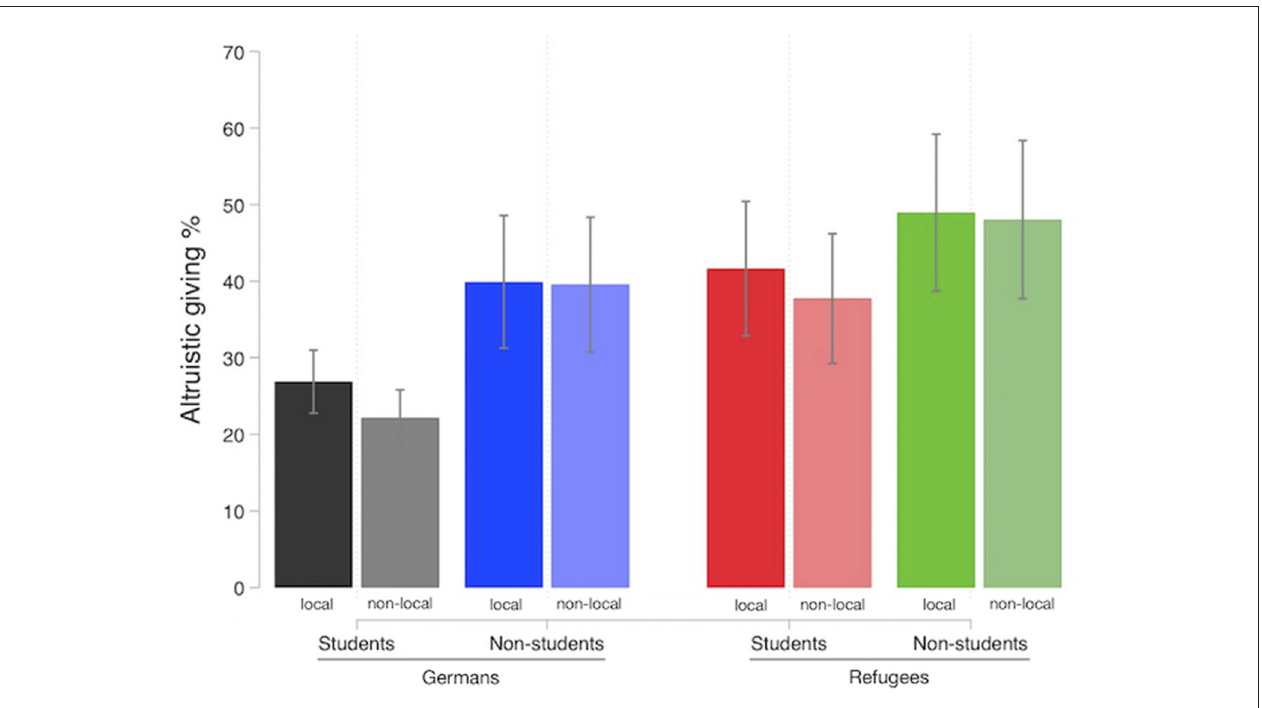
FIGURE 2 | Altruistic giving (in percentages) for all groups of receivers: German students, non-student Germans ( = social welfare recipients), refugee students and non-student refugees. Bars in saturated colors represent the receivers with a shared local identity whereas bars in brighter colors represent non-local receiver groups. Error bars represent 95% confidence